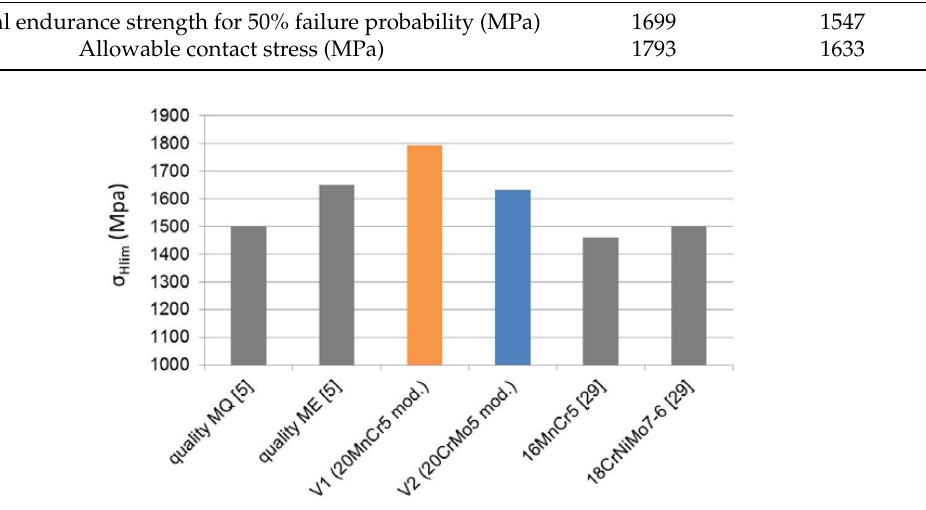
Figure 16. Comparison of the determined pitting strength number of newly developed case carburized steels vs. strength levels of DIN 3990 and literature data of reference steels.